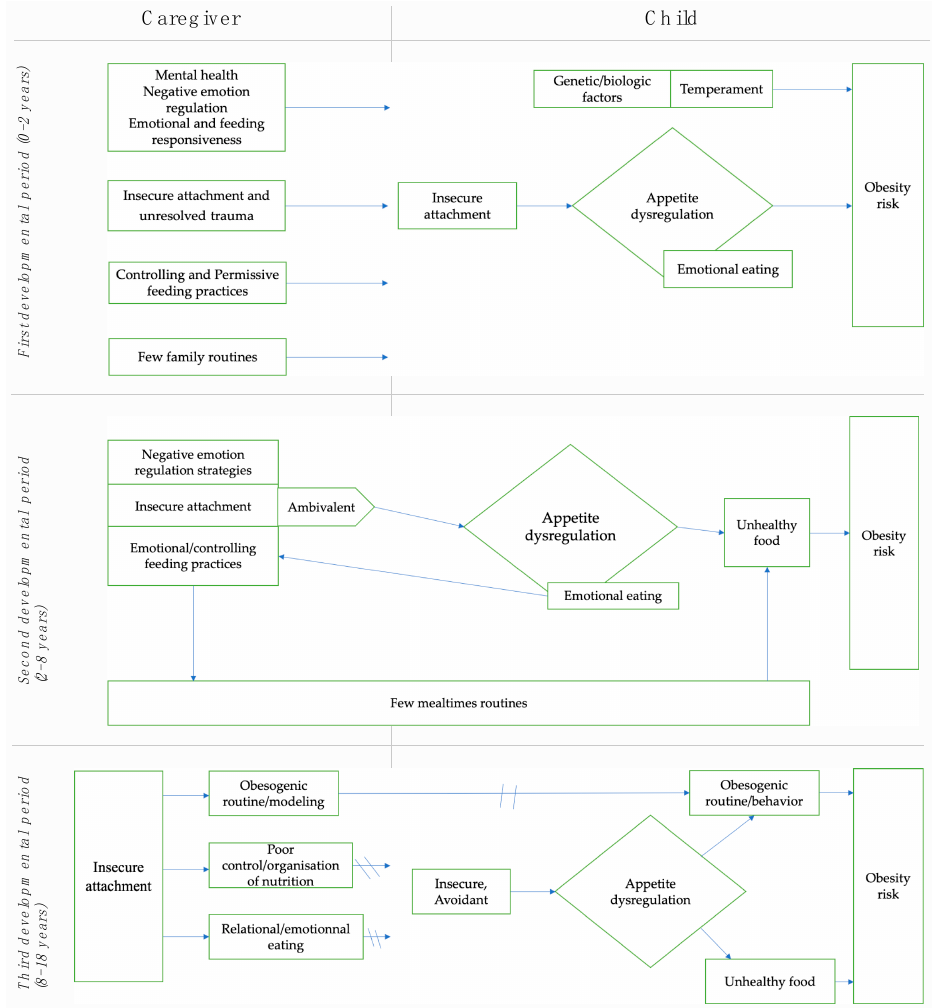
Figure 2. Synthesis of the literature review for the three developmental periods.